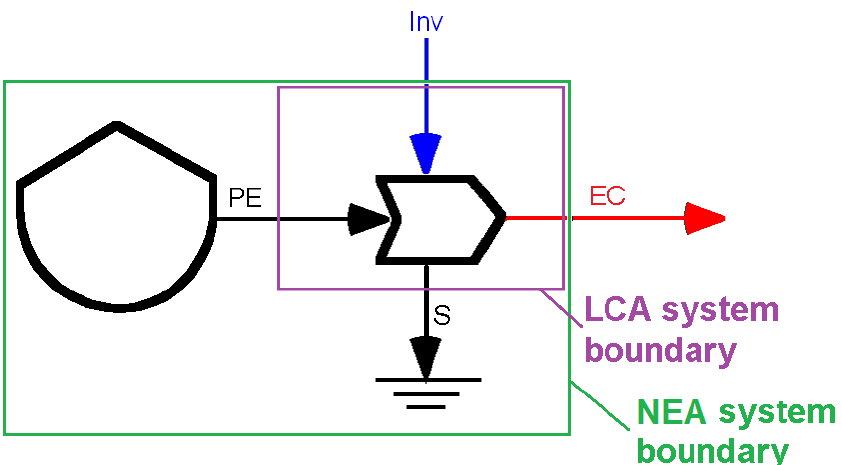
Figure 5. Simplified diagram of a generalized energy supply chain, illustrating the different boundaries set by life cycle assessment (LCA) and net energy analysis (NEA). PE = Primary Energy; Inv = energy “investment”; EC = Energy Carrier (the energy “return”); S = energy dissipated to the environment.